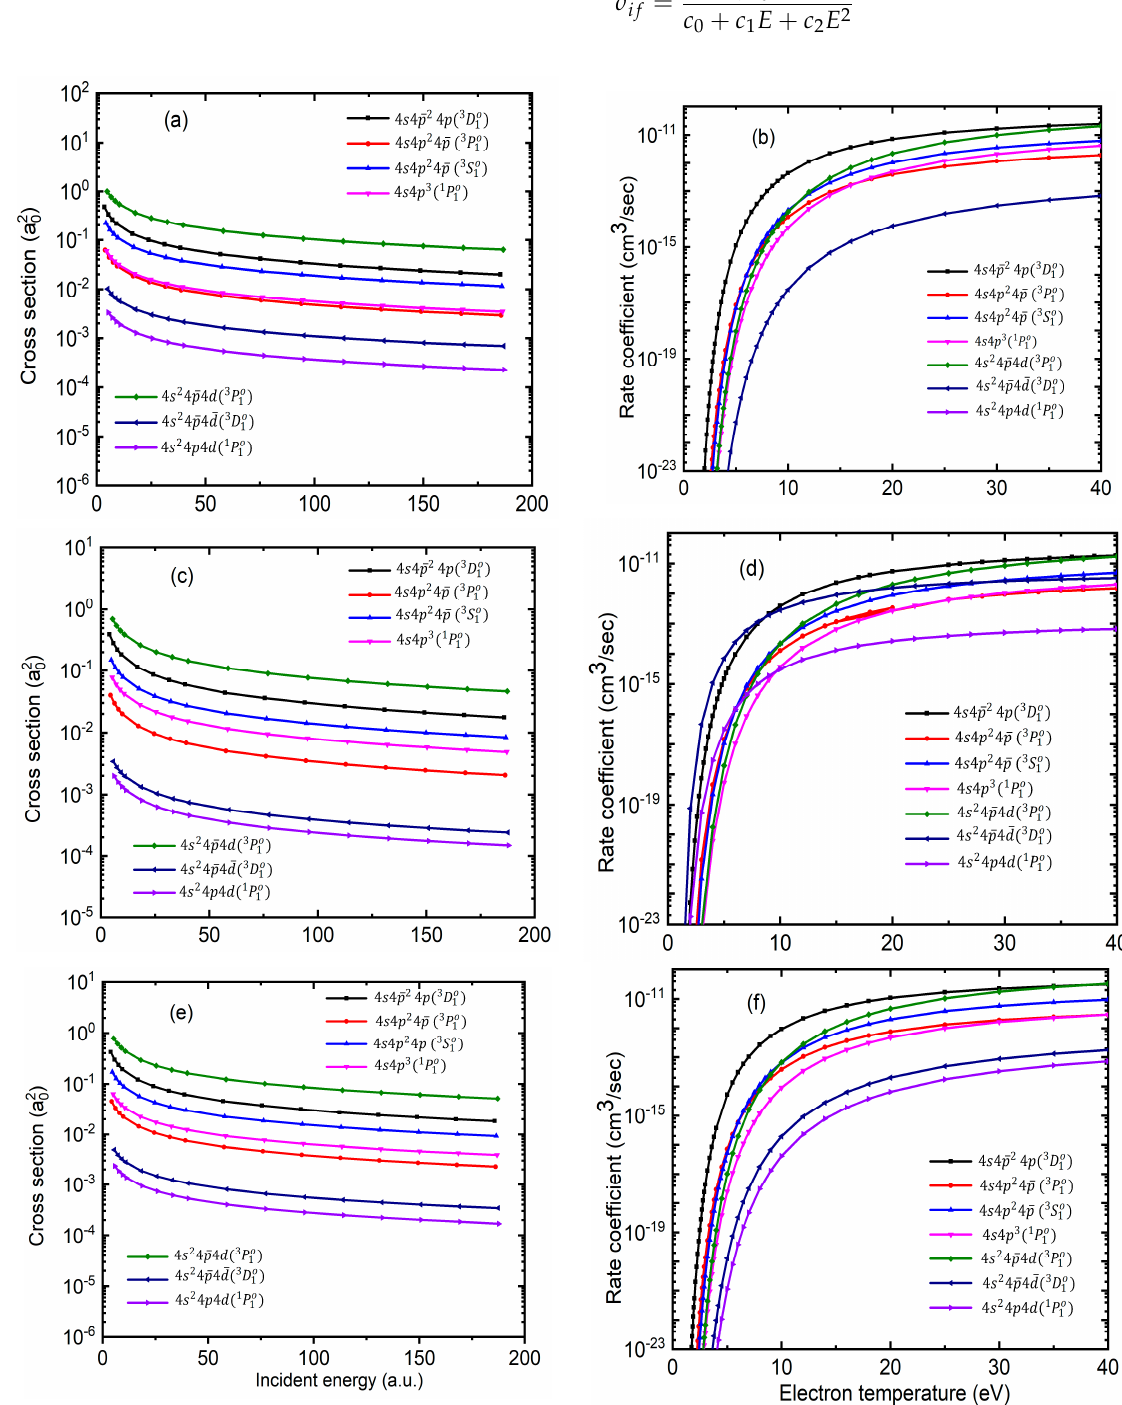
Figure 2. Integrated cross section vs incident electron energy (left panel) and excitation rate coefficients vs electron temperature (right panel) for ( a , b ) Te 20+ , ( c , d ) Sb 19+ and ( e , f ) Sn 18+ ions.